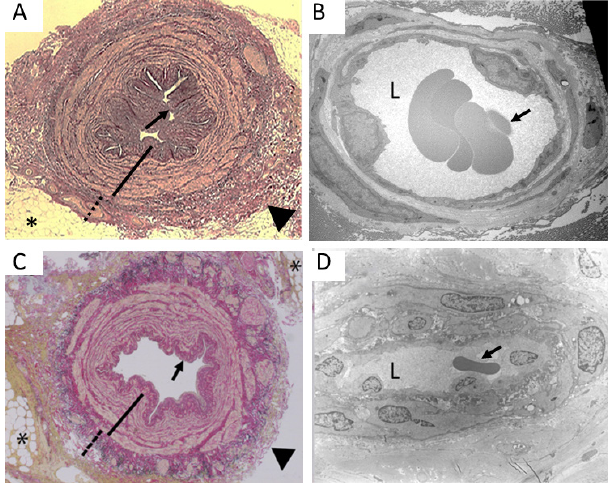
Fig. 5 - Histology findings of no-touch and endoscopic saphenous vein grafts for coronary artery bypass grafting. Left panels show representative transverse sections of no-touch (A) and endoscopic no-touch (C) saphenous vein grafts with preserved perivascular adipose tissue (*), a folded intima (small arrow), a thick intima (continuous line), and an intact/undamaged adventitia (broken line). Right panels show transmission electron microscopy images of open adventitial vasa vasorum lumen (L) containing erythrocytes (small arrow) in no-touch (B) and endoscopic no-touch (D) saphenous vein grafts. (A from Dashwood et al. [9] , 2009; B from Ahmed et al. [24] , 2004; C and D from Yoshino et al. [61] , 2020).